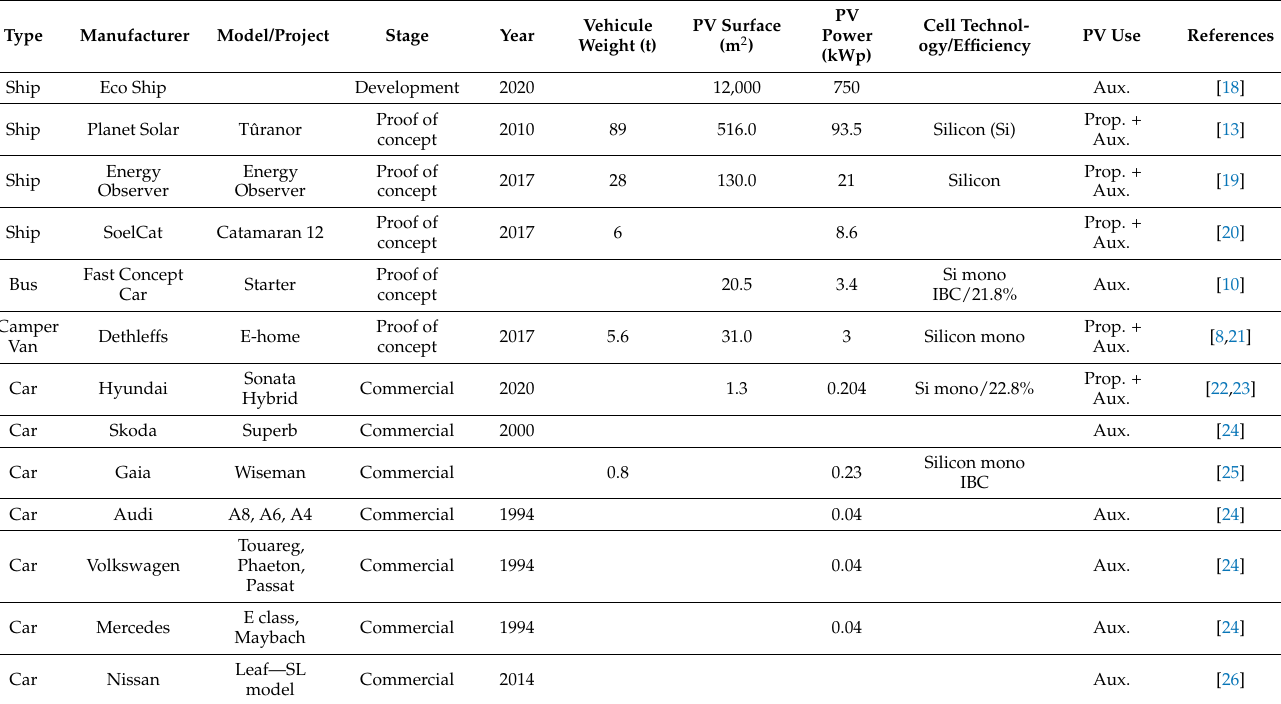
Table 1. Noncomprehensive chart of VIPV products and R&D initiatives.